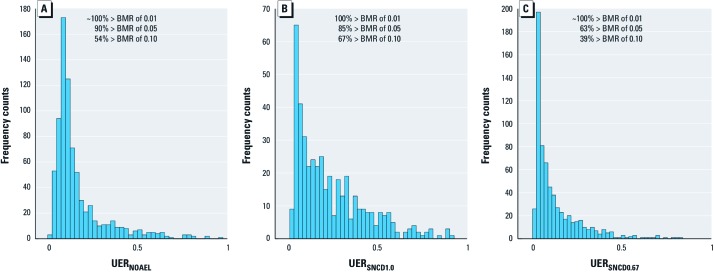
The UER at the NOAEL (A), SNCD1.0 (B), and SNCD0.67 (C). The percentages of data sets exceeding standard BMR (extra risk) levels of 0.01, 0.05, and 0.1 are given.